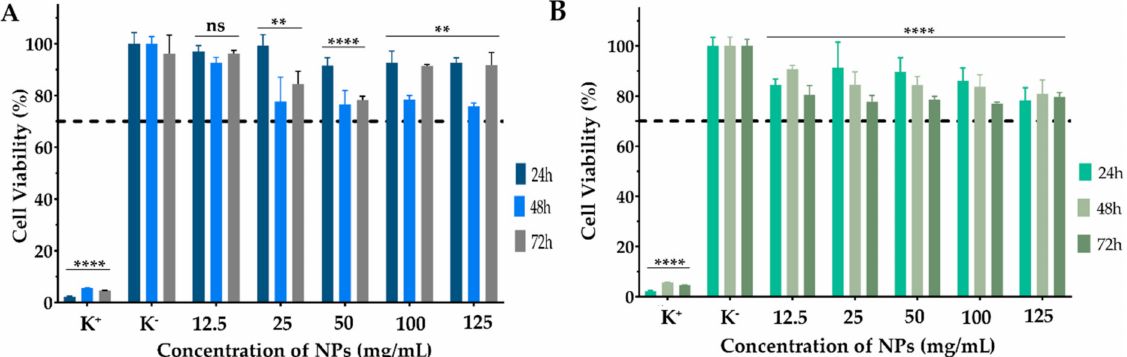
Figure 7. Characterization of the biocompatibility of ( A ) Zein_HA NPs cryoprotected with 5% man- nitol and ( B ) ZeinCPX_HA cryoprotected with 5% mannitol NPs in contact with NHDF cells during 24 h, 48 h and 72 h. Data are presented as mean ± SEM, n = 5, ns—not statistically significant, ** < p = 0.001, **** < p = 0.0001, values marked with asterisks are statistically different from the mean of K −